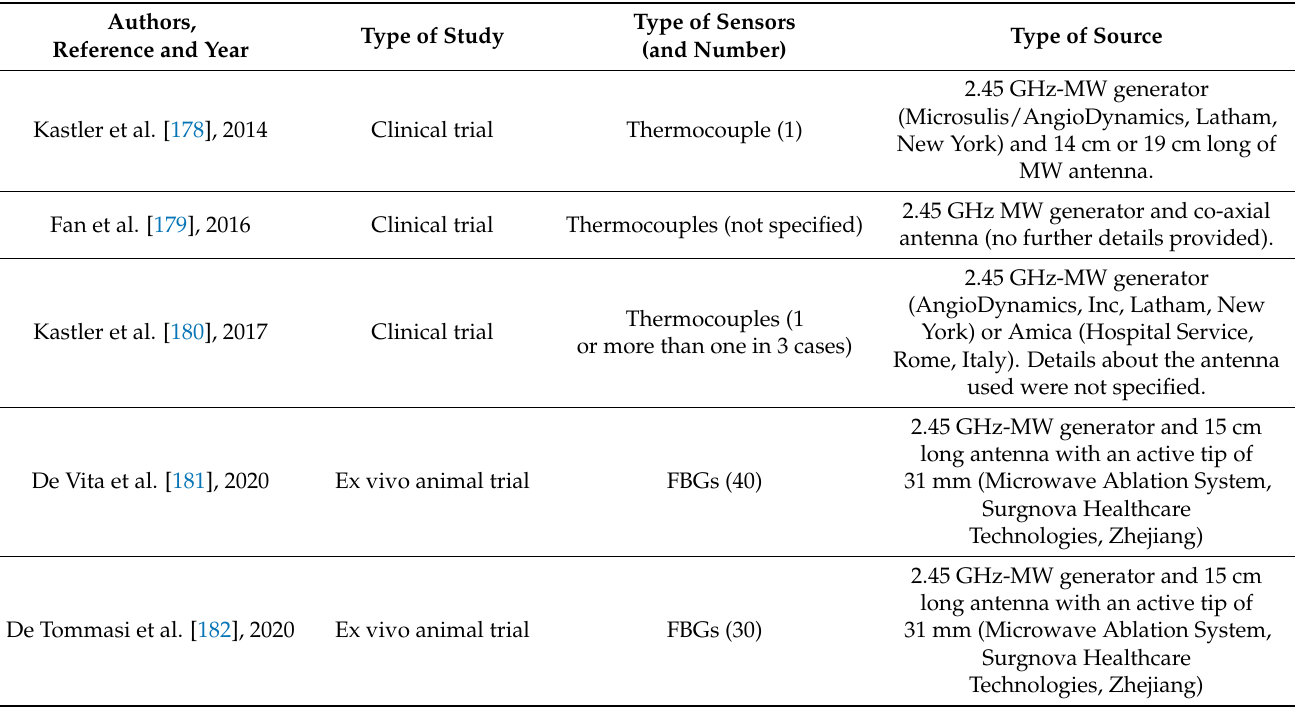
Table 4. Studies related to temperature monitoring during bone